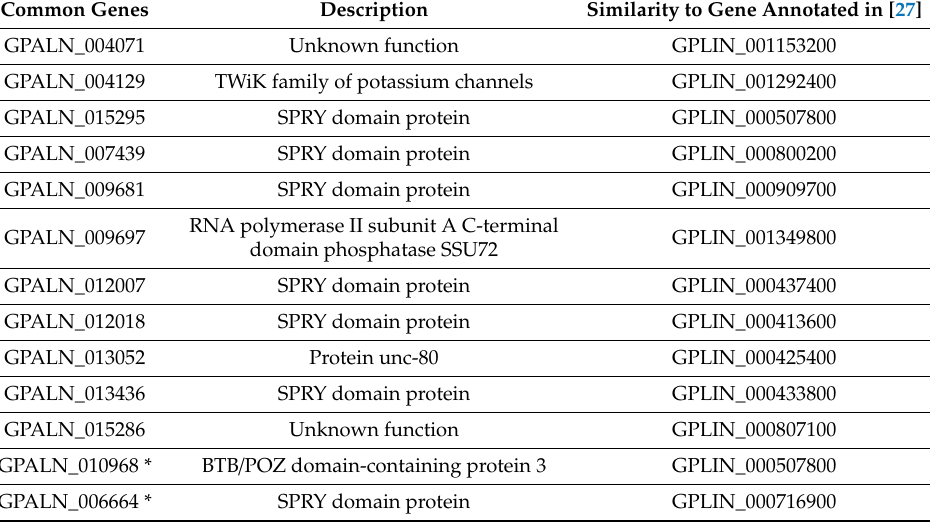
Table 2. Annotated genes identified in common in both PenSeq and ReSeq variant calling analyses. The third column indicates the annotated gene in the current G. pallida genome [30] assembly as generated by BLASTp search. In the two genes marked with an asterisk (*), the variant calls were not found in the same populations between the two analyses (possibly as an artefact result and not as candidate Avr